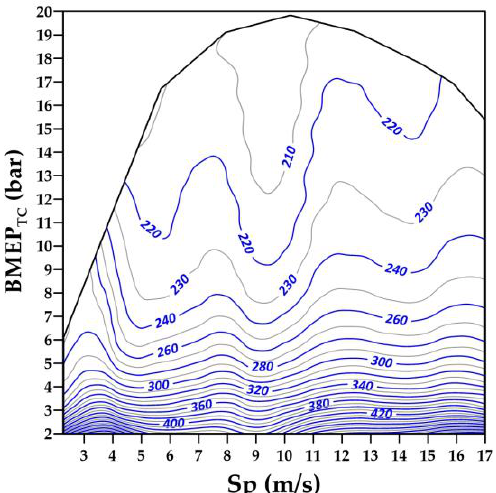
Figure 14. Brake-specific fuel consumption (g/kWh) of the reference turbocharged engine, as a function of load and mean piston speed.